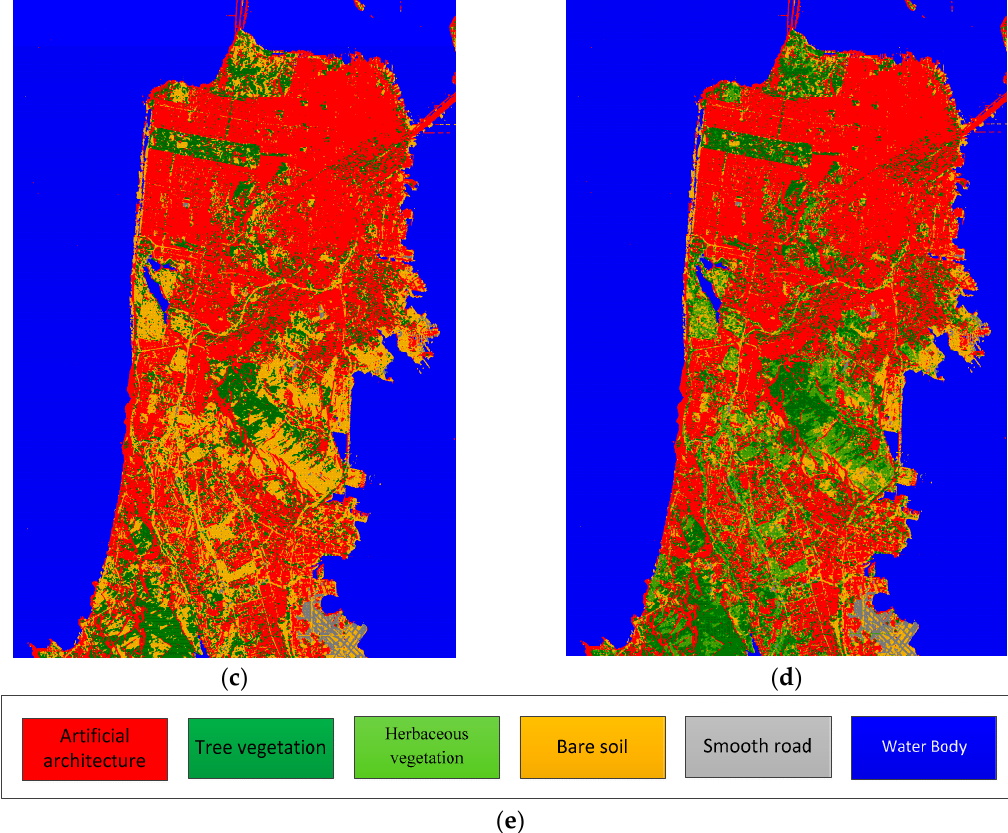
Figure 10. ( a ) Part of RF classification result; ( b ) corresponding area after majority vote; ( c ) whole classification result after majority vote; ( d ) updated result for the “Bare soil with little vegetation” class, divided into Bare soil and Herbaceous vegetation classes; and ( e ) the colormap for each